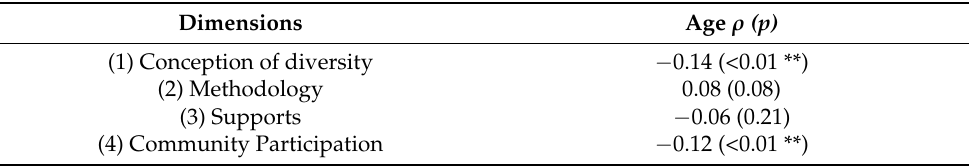
Table 5. Correlations between the Dimensions and the age group